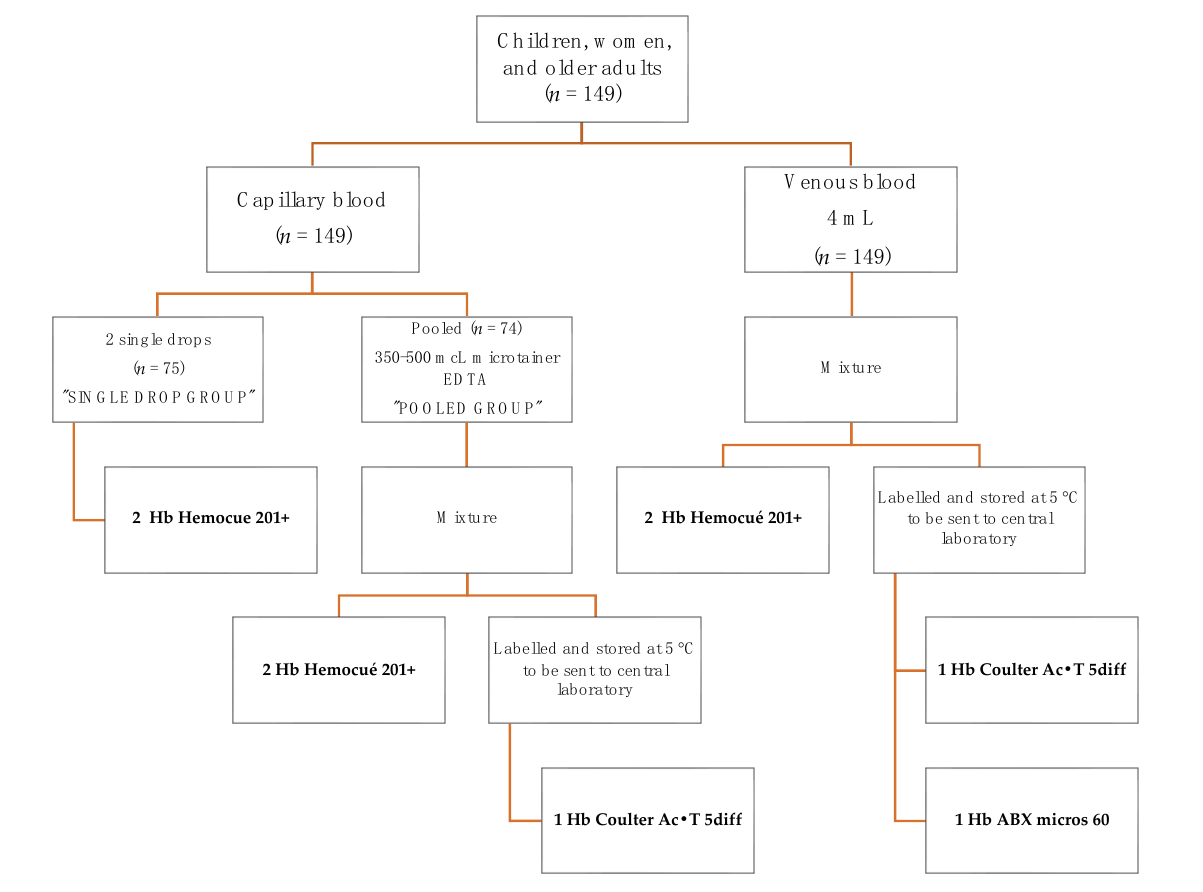
Figure 1. Procedures and measurements.